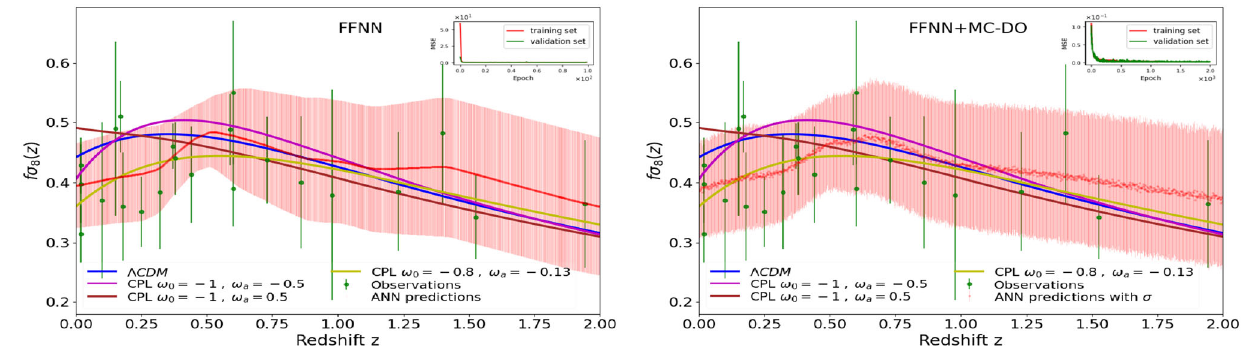
Fig. 3 Neural reconstructions for f σ 8 ( z ) (red lines) and their respec- tive errors. The original observations are in green with their uncertain- ties. Left: The f σ 8 reconstruction performed by FFNN alone. Right: f σ 8 reconstruction predicted by the FFNN using Monte Carlo dropout, the averages of 100 executions of MC-DO are indicated with the red